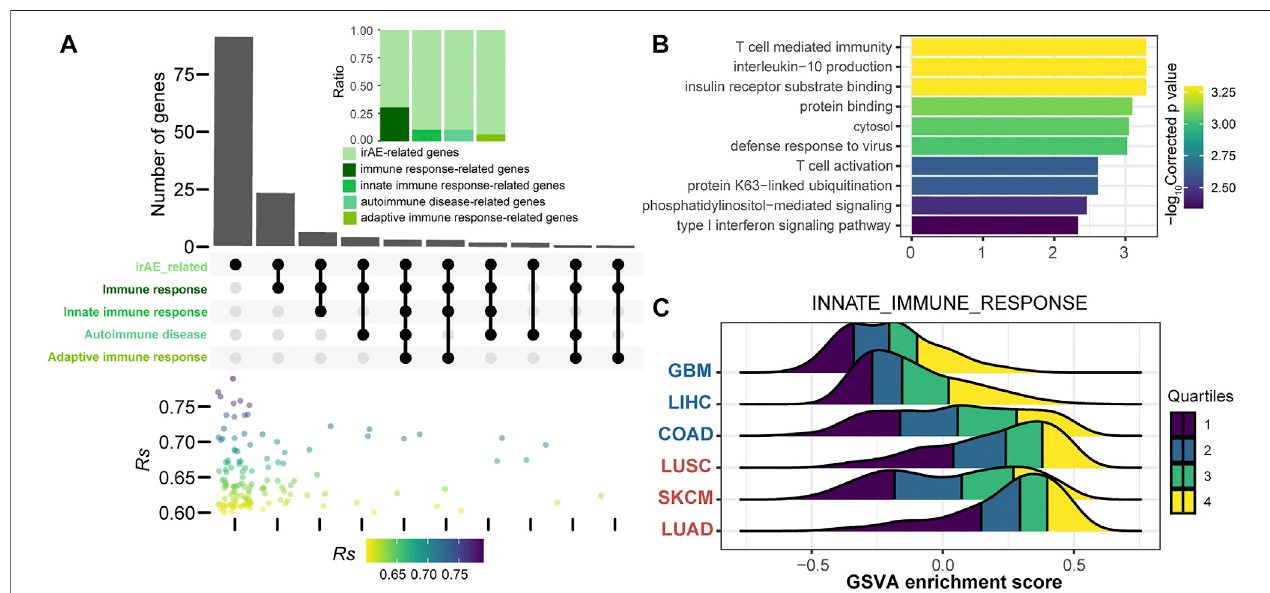
FIGURE4| FunctionalcharacteristicsofirAERORsigni fi cantlycorrelatedsplicingisoforms. (A) TheintersectionsofparentalgenesofhighlypositivelyirAEs-related splicingisoforms( Rs > 0.6, p value < 0.05)withimmune-relatedandautoimmunediseasegenesets.Thecolordotplotshows Rs valuesofirAEs-relatedsplicingisoforms in each corresponding subset. The upper inset shows the proportion of irAE-related splicing isoforms annotated into the corresponding gene sets. (B) Functional enrichment analysis of irAEs-related splicing isoforms associated with innate immune response (top 10). Bar plot shows -log 10 Corrected p values of signi fi cantly enriched pathways. (C) GSVA enrichment scores of innate immune response in patients with high and low irAE risk.